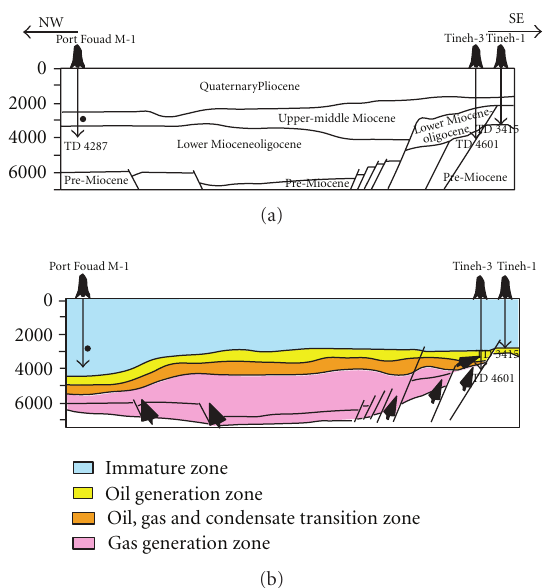
Figure 13: NW-SE cross sections showing the migration paths through the Nile Delta (modified after